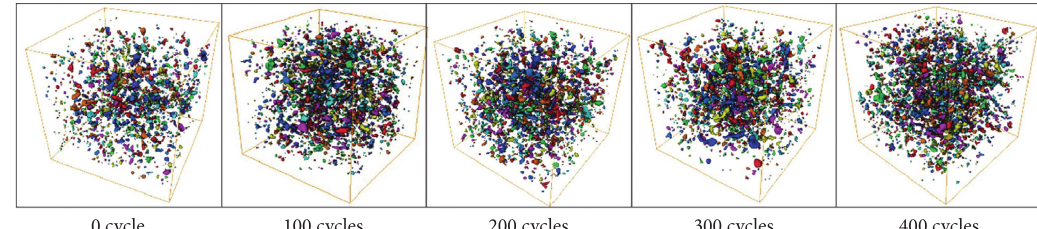
Figure 15: Cube-pore image of 6% CaO expansive concrete (C-6) under different freeze-thaw cycles.